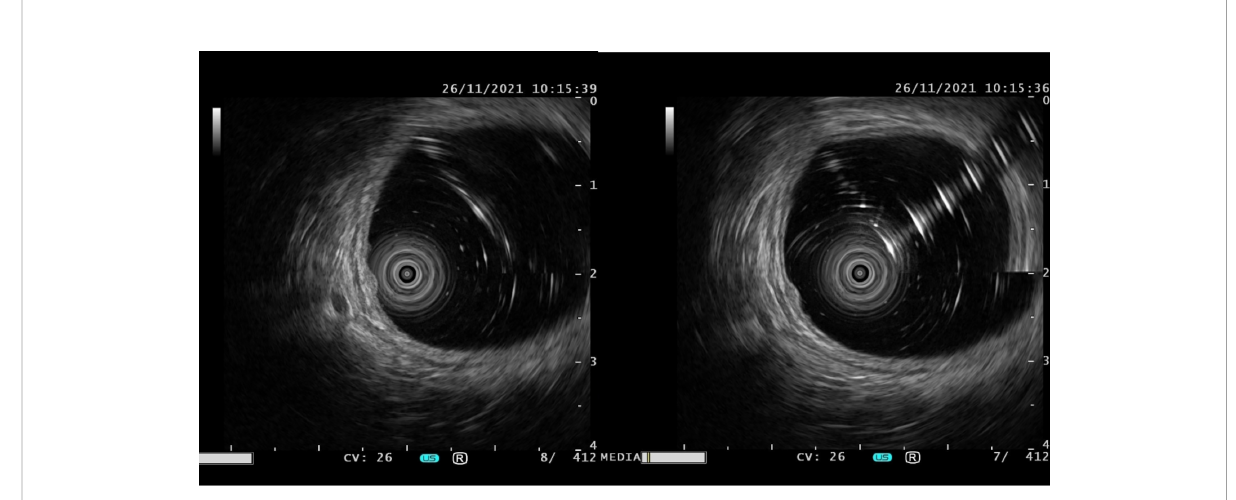
FIGURE 2 The typical manifestations of lesions under endoscopic ultrasonography were originated from the mucous layer or submucosa, and the internal echo was homogeneous, showing low or moderately low echo, and the boundary was